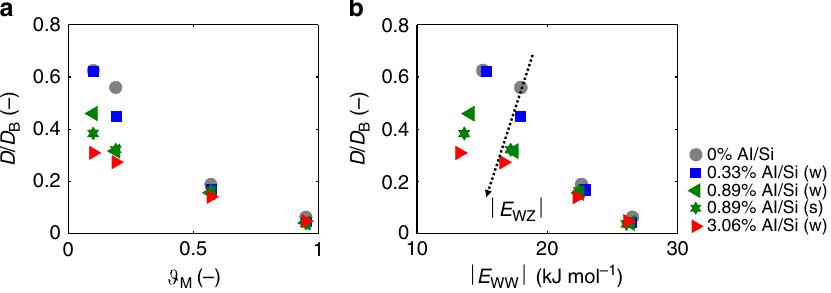
Figure 2 | Self-diffusivity of water in defected MFI membranes. ( a ) Self-diffusion coefficient of water ( D ) nanoconfined in defected zeolite crystals. D is normalized by D B (self-diffusion coefficient of bulk water) and evaluated at different W M (pore hydration). ( b ) Self-diffusion coefficient of water nanoconfined in MFI zeolites with various defect concentrations versus water–water-specific interaction energies ( E ww , see Supplementary Equation (1)). The effect of the water–zeolite-specific interaction energy ( E wz , see Supplementary Equation (2)) on D is also shown. In the legend, (w) refers to ‘weak’ silanol defects ( q H ¼ 0.45 e ; q O ¼ (cid:2) 0.9 e ), whereas (s) to ‘strong’ ones ( q H ¼ 0.65 e ; q O ¼ (cid:2) 1.1 e ). According to the specific adsorption-infiltration isotherm (see Supplementary Fig. 2), the considered pore hydration may involve either adsorption or infiltration